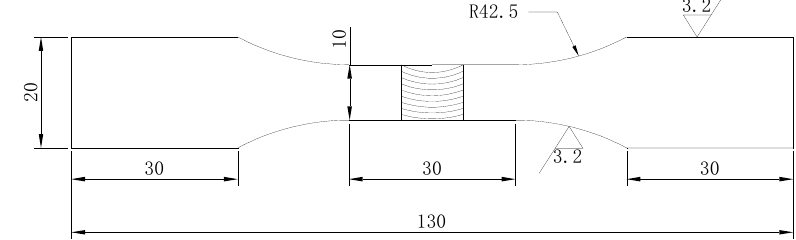
Figure 1. Shape and size of the fatigue specimen.